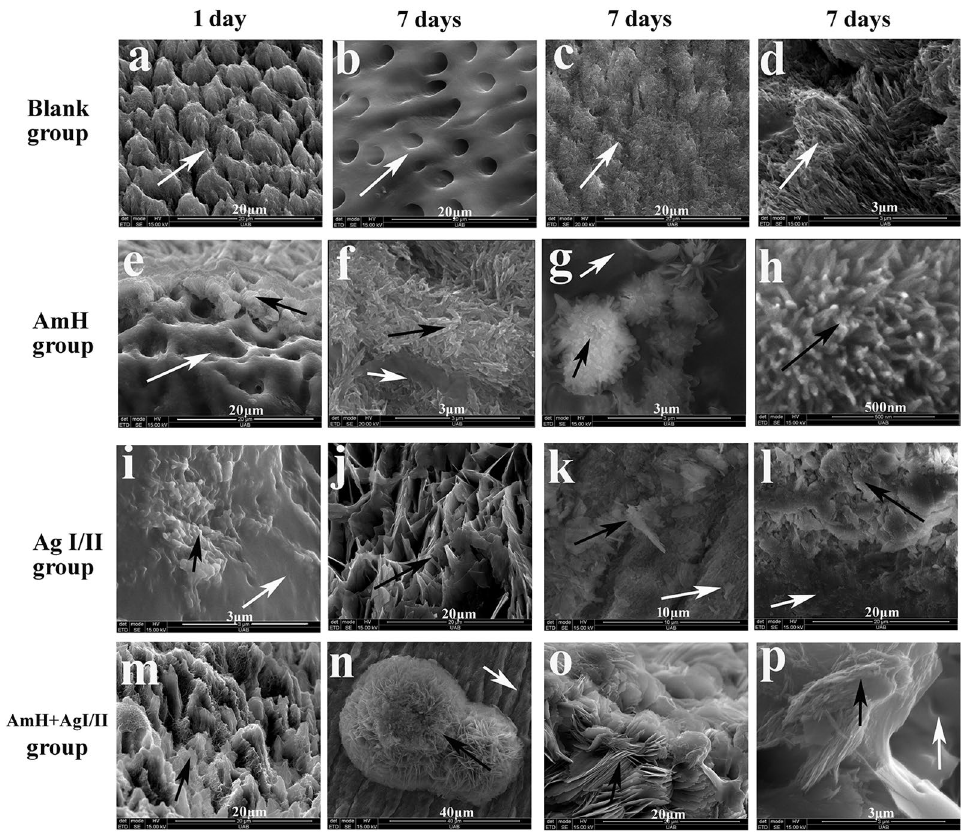
Figure 4. SEM images of newly grown crystals (black arrows) on the tooth structure (white arrows) after mineralization. ( e , i , m ) are the early stage of mineralization (1 day), the other reactions continued 7 days. ( a – d ) normal tooth, ( a ) demineralized enamel rod; ( b ) demineralized dentin tube; ( c ) demineralized rod and inter- rod woven; ( d ) bundle crystals in enamel rod at high magnification. ( e – h ) AmH group, ( e , f ) 0.5–1.2 μm thick new layer attached to enamel rod and dentin tube; ( g ) hedgehog crystals globule; ( h ) radial needles/rods which look similar to bundle crystals in normal enamel rod. ( i–l ) Ag I/II group, 1–10 μm thick new layer deposited on surface of tooth ( i ) polygonal; ( j ) fractured sheet over 8 μm; ( k ) irregular block; ( l ) tiny stumps. ( m – p ) AmH + Ag I/II group, petal-like crystals with size of 2–20 μm, ( m ) prototype of sheet shape; ( n ) spherical sheet type same in glass surface; ( o ) petal crystals in sphere; ( p ) parallel needle-like structure attached to the